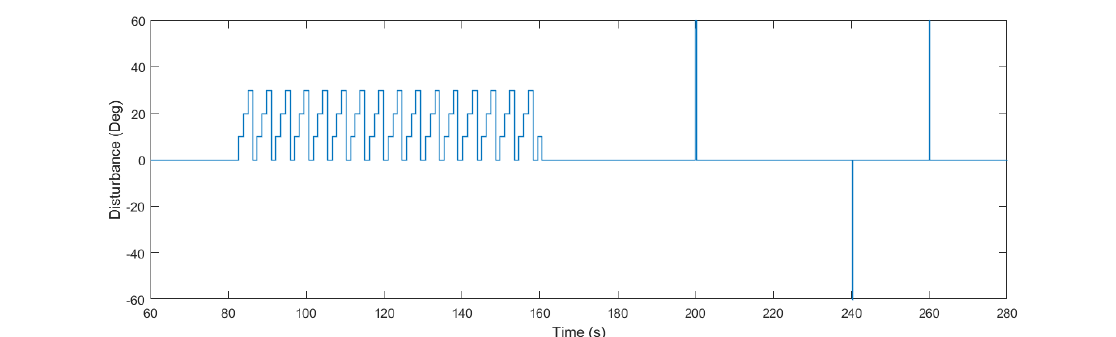
Figure 10. Disturbance applied to the system. Solid black line: proposed algorithm. Dot-dashed blue line: algorithm in [30]. Dashed red line: auxiliary PI controller.